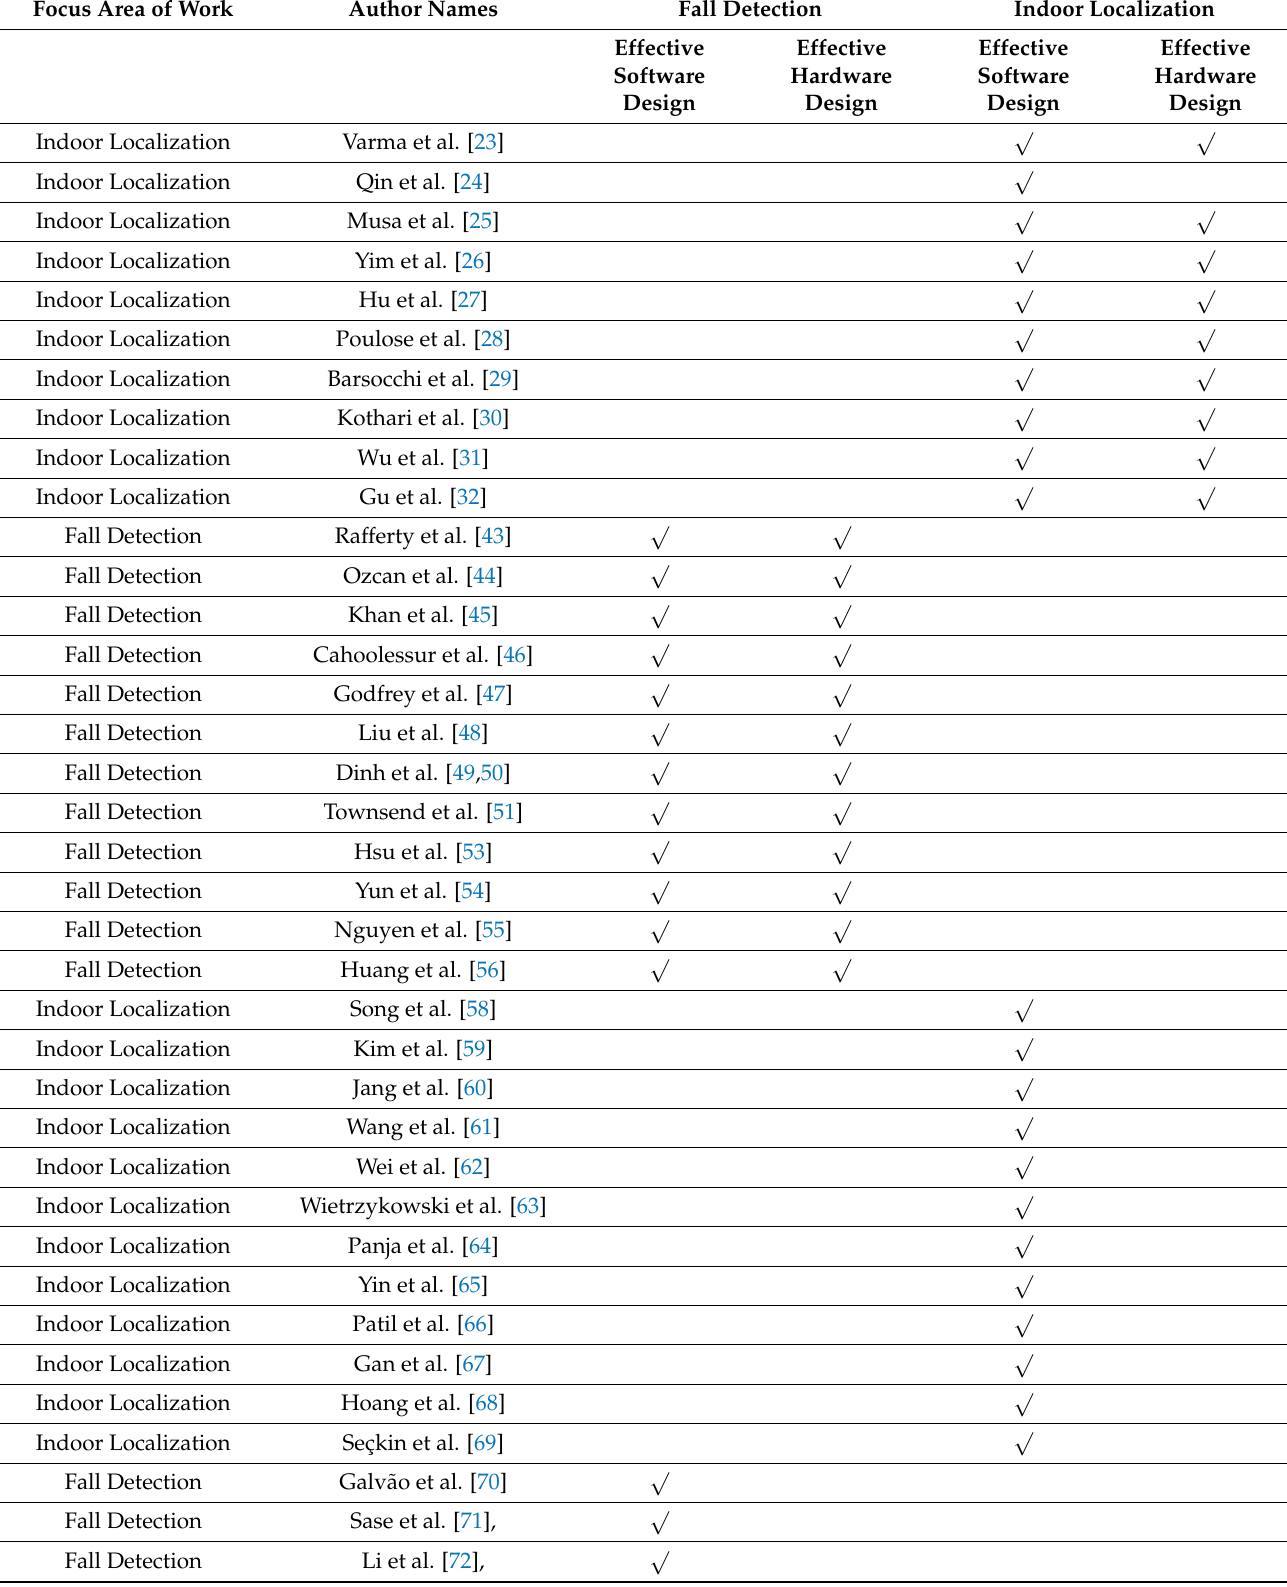
Table 3. Comparison of the functionality of our system with prior works in this field in terms of the effectiveness of the software design and hardware